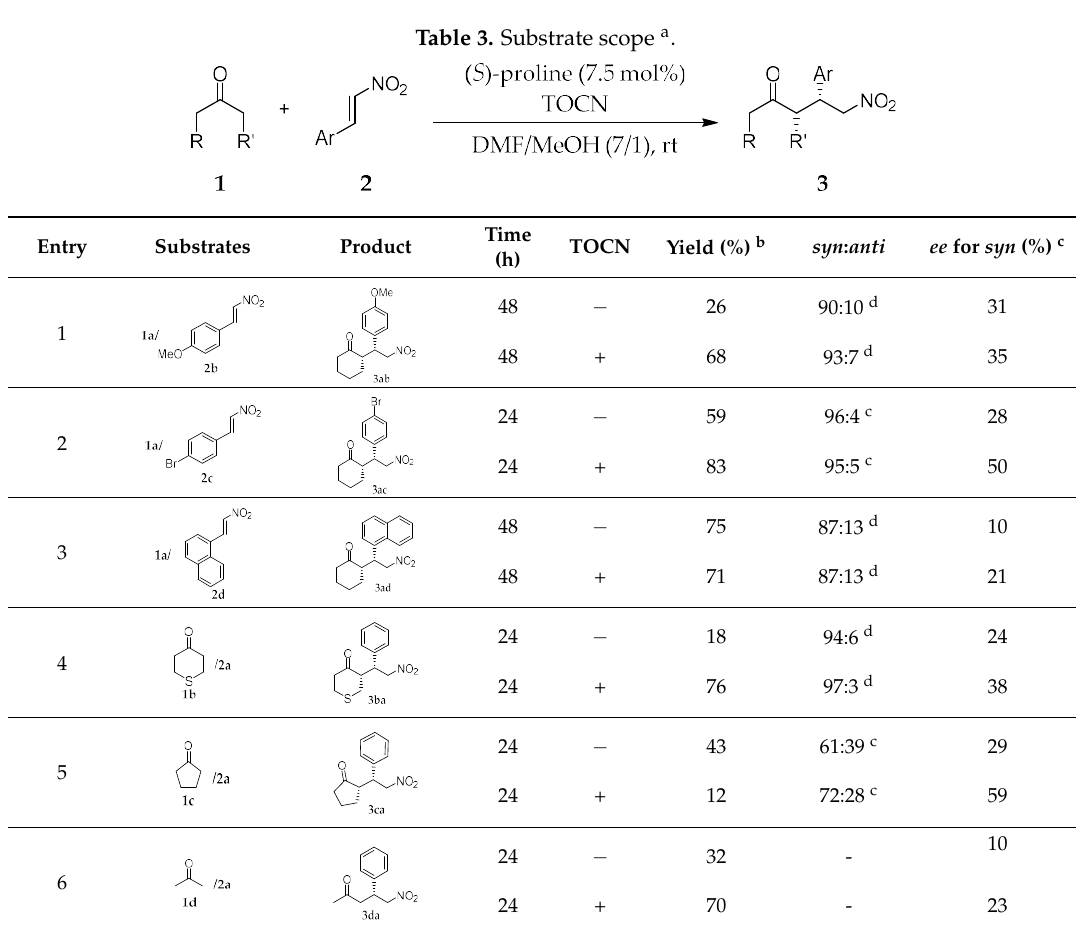
Molecules 2019 , 24 ,